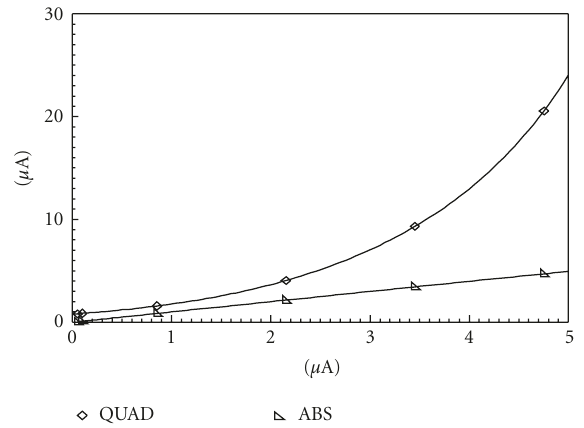
Figure 7: Simulated absolute value and quadratic responses of the